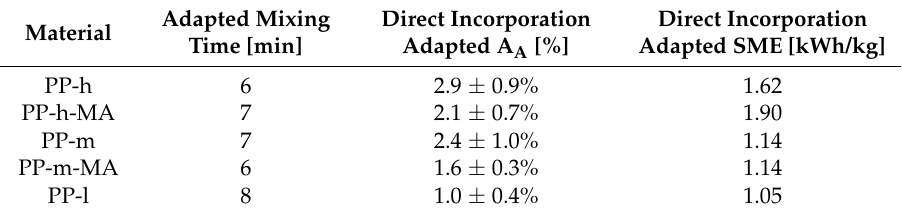
specific mechanical energy (SME) measured under adapted